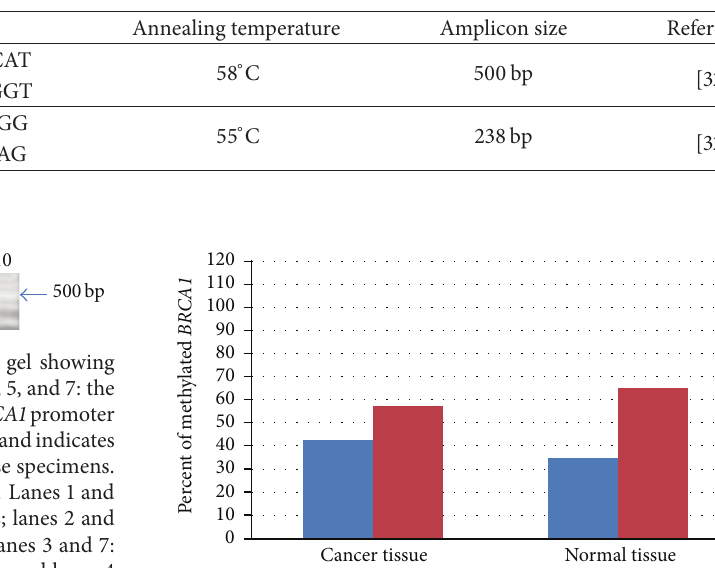
Table 1: Primers used for PCR amplification after HpaII digestion, along with the target band size and annealing temperatures.